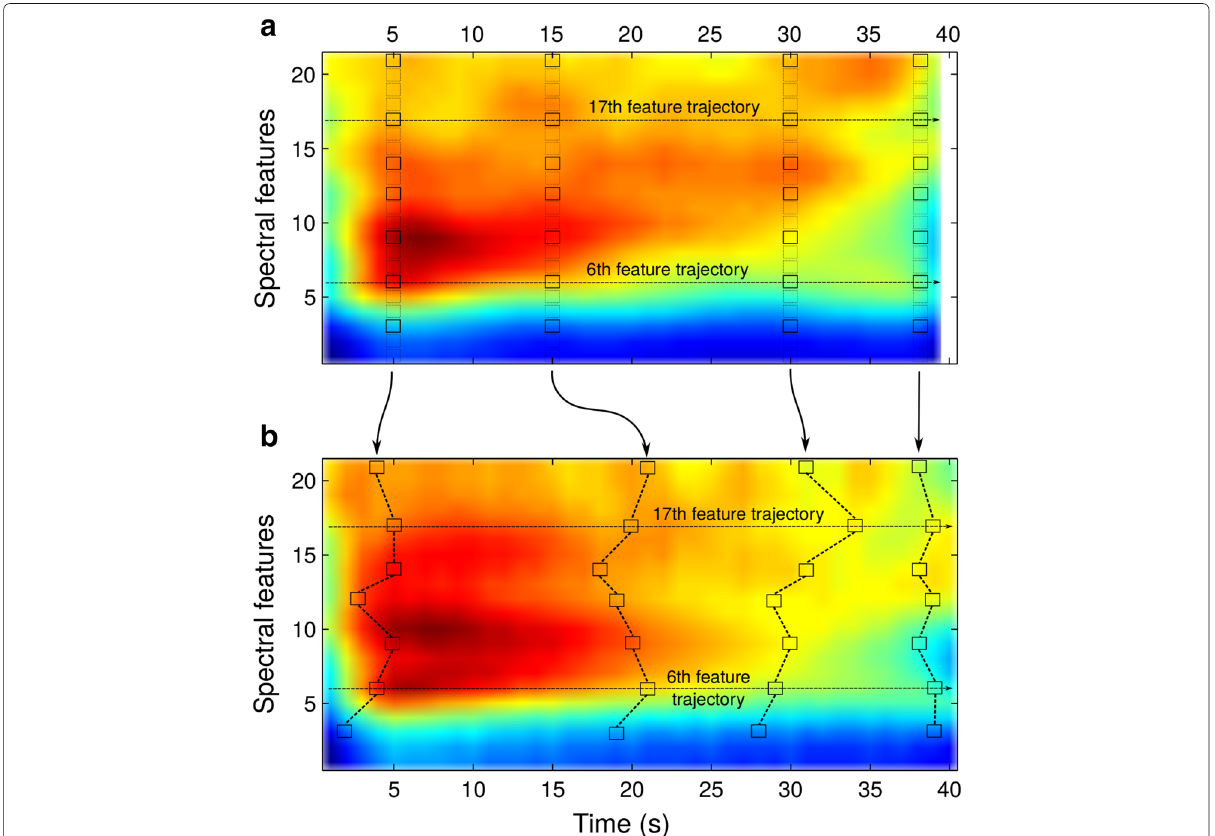
Fig. 2 Alignment by FTDTW of spectral features extracted from the triphone b-aa+dx as uttered by a male speaker mrfk0 and b by female speaker fdml0 in the TIMIT corpus